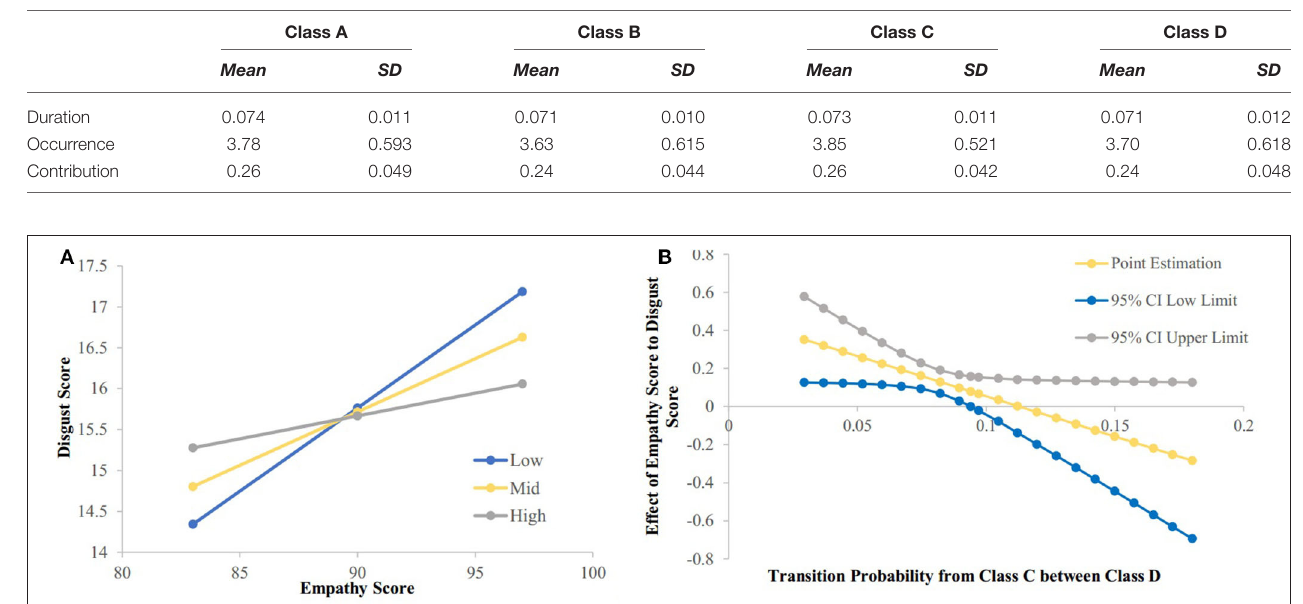
TABLE 1 | Descriptive statistical of the average duration, occurrence and contribution of EEG-ms.